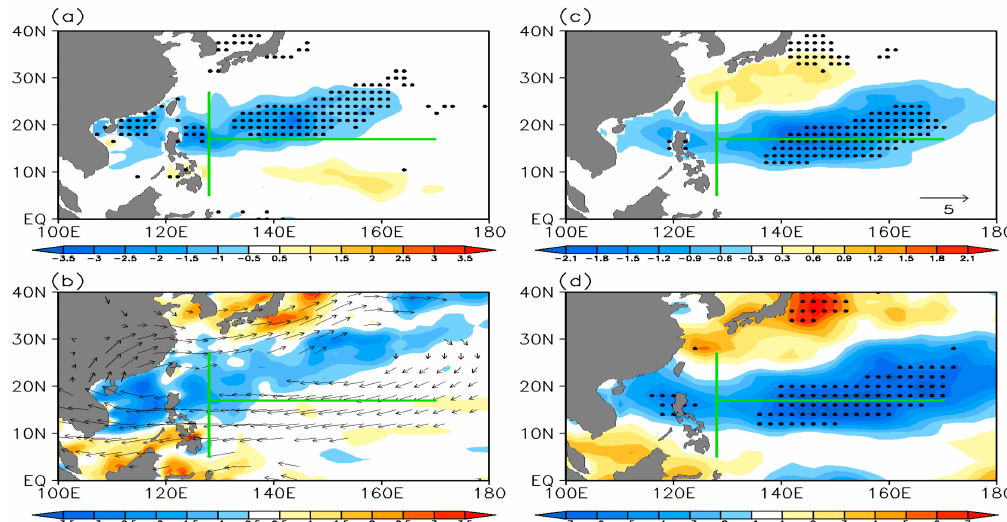
Figure 4. The difference in ( a ) GPI changes induced by VOR , ( b ) 850 hPa relative vorticity (shading) and wind fields (vectors), ( c ) GPI changes induced by RH , and ( d ) the RH at 700 hPa between the positive and negative phases of PC1. The dots mark regions where the differences are significant at the 95% confidence level. For the changes in wind fields at 850 hPa in ( b ), only areas where the differences are statistically significant at the 95% confidence level are shown.